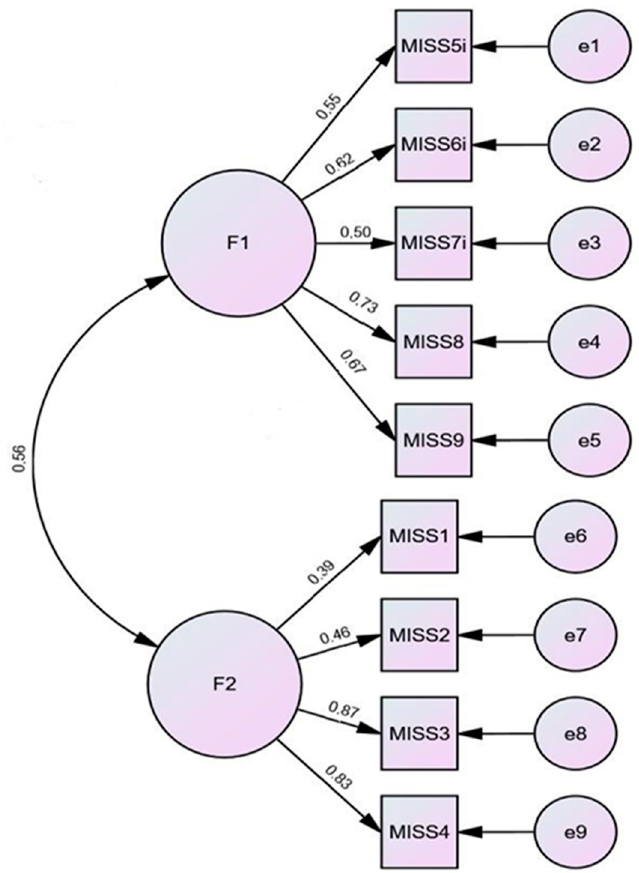
Figure 2. Confirmatory factor analysis of G-MISS-HP; 2-factor model. Note. Values on paths correspond to standardized estimates.